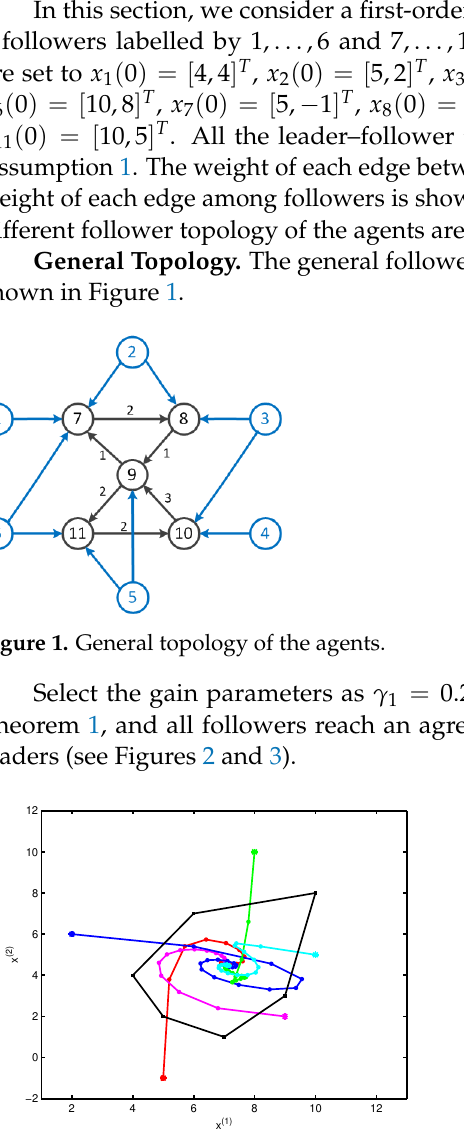
Figure 2. Trajectories of agents with general topology.